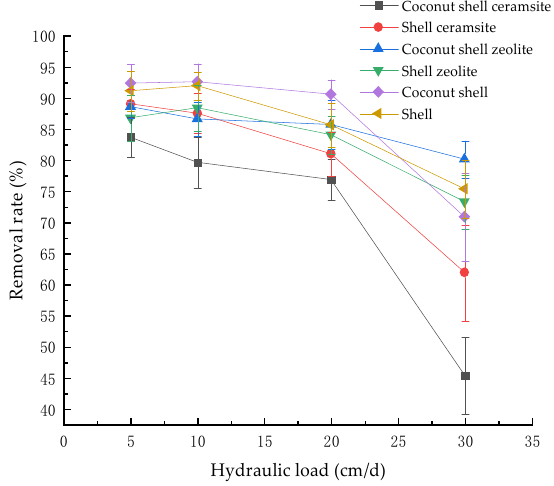
Figure 10. Removal effect of biochar-constructed wetland on total phosphorus.